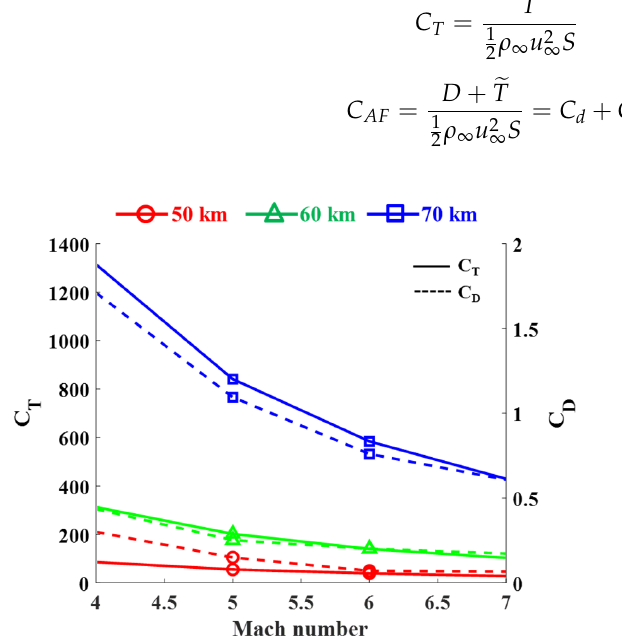
Figure 7. Thrust and drag coefficient in the entry-burn phase.